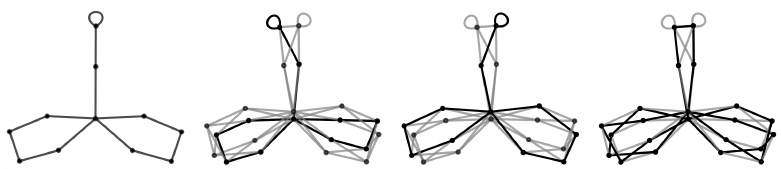
Figure 15. Illustration of the twining of vertices that results when p is multiplied by 2. A 25 is compared to A 2 · 25 The middle two panels show the two copies of A 25 contained in A 2 · 25 . The last panel shows the remaining edges. Twin vertices do not share an edge.